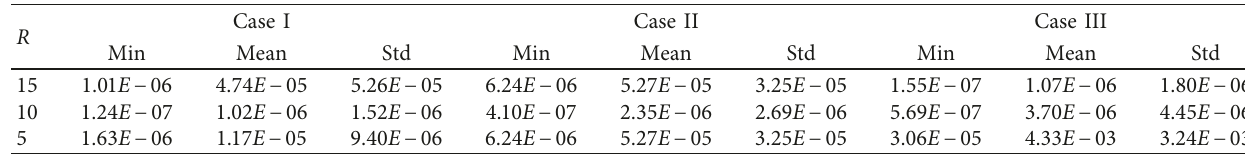
Table 7: Statistics of root mean square error in our solutions for different cases and scenarios of the homogenous circular sector.